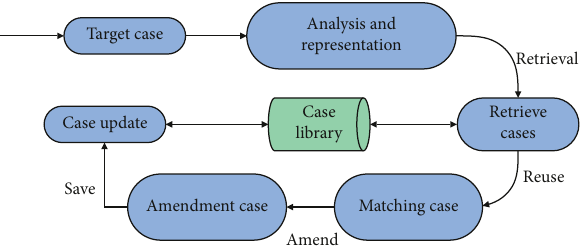
Figure 3: Problem-solving process based on case